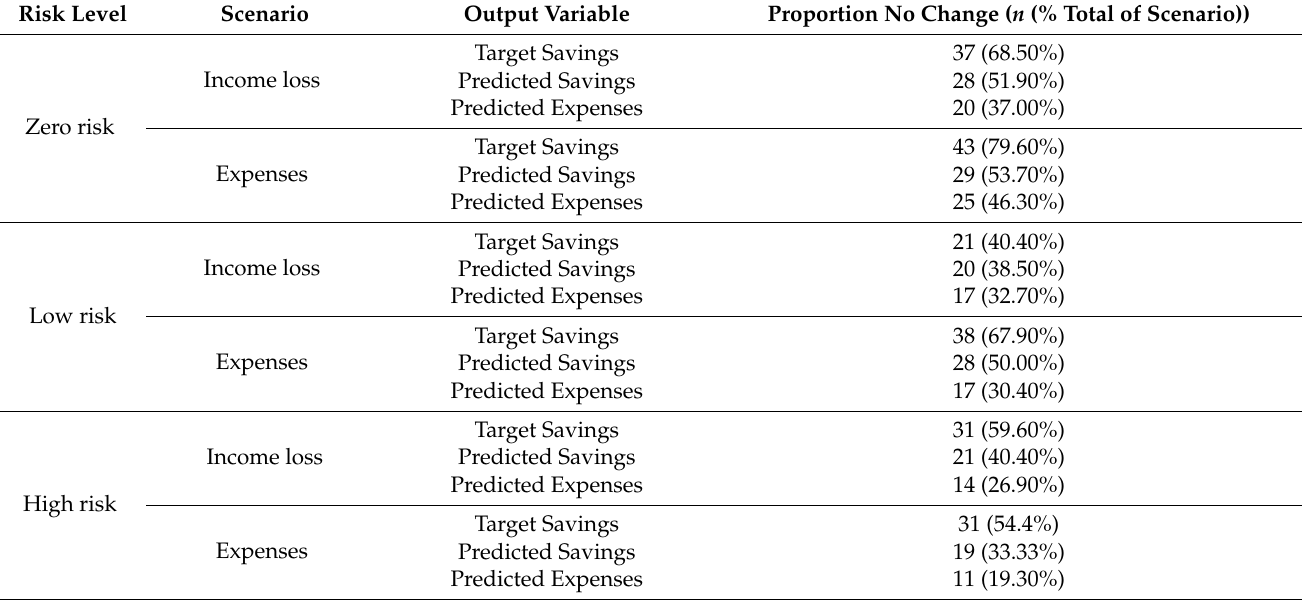
Table A3. Proportion of people who don’t change their